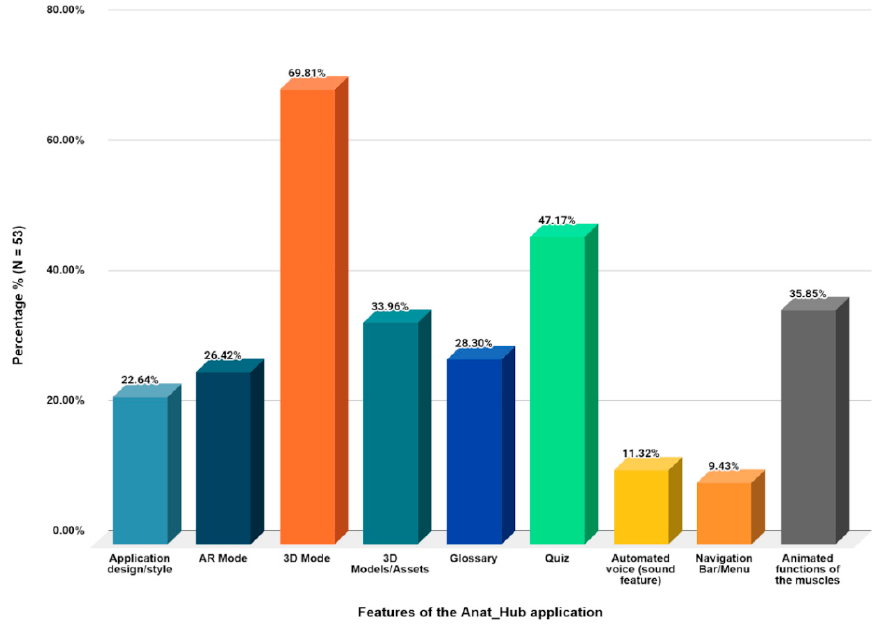
Figure 17. The most-liked features of the Anat_Hub mobile application. Overall, the application was well received by respondents and all indicated their willingness to make use of the Anat_Hub application to study the musculoskeletal system, while 96.2% said they will recommend the use of this application to others (Figure